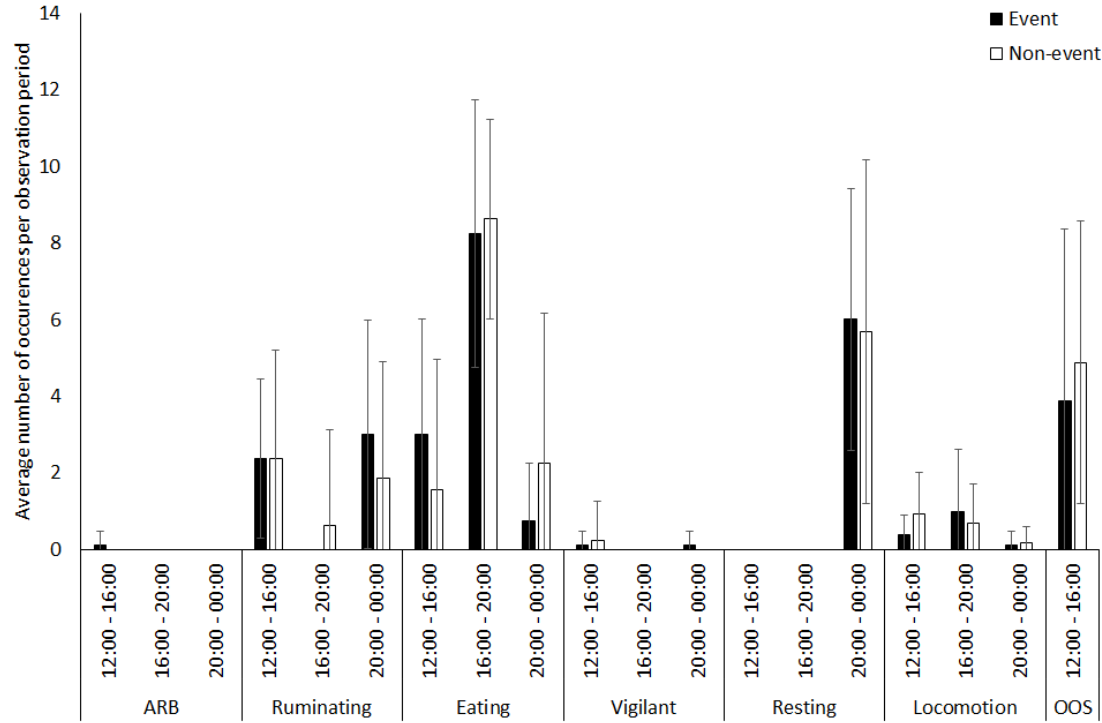
Figure 9. Activity budget data for two giraffes (average number of occurrences of each behaviour within the group per observation period ± standard deviation) from 12:00–00:00 during event nights and non-event nights. Each 12 h period was split into three time periods. ARB: abnormal repetitive behaviour, OOS: out of sight of the observer.